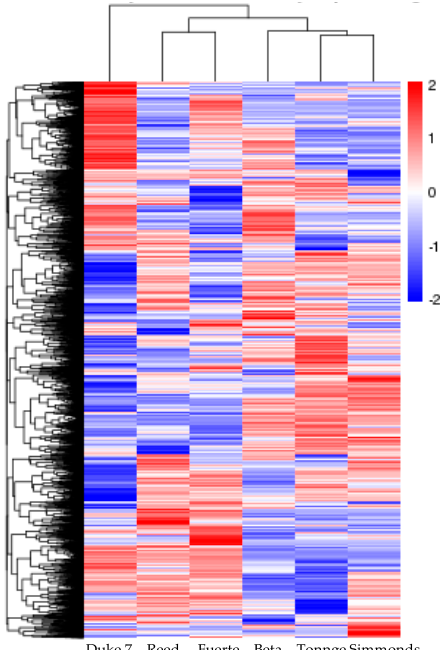
Figure 3. Heat map of differentially expressed genes of six avocado cultivars transcriptomes. The various shades in the boxes show similar tendencies of gene expression. Labels along the right side correspond to unigenes names (see Table S6). Table 3. The number of differentially expressed genes (DEGs) identified by pairwise comparisons of gene expression levels in six avocado accessions.